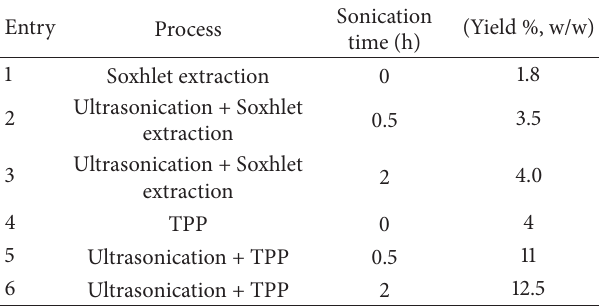
Table 1: Effect of ultrasonication on oil yield by Soxhlet extraction and by TPP. The algal suspension was sonicated, filtered, and subjected to Soxhlet extraction with hexane or TPP as described in the methods, Section 2.5. Each set was run in triplicate and the variation between the experimental data was within